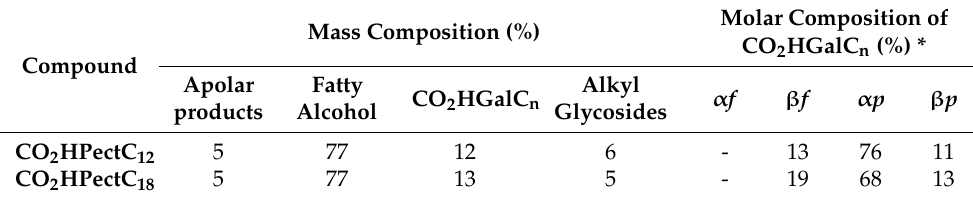
Table 3. Mass composition (* determined by integrating NMR signal for anomeric protons) of the mixtures CO 2 HPectC n obtained during the transformation of pectin into n -alkyl D -galactosidu- ronic acids CO 2 HGalC n.